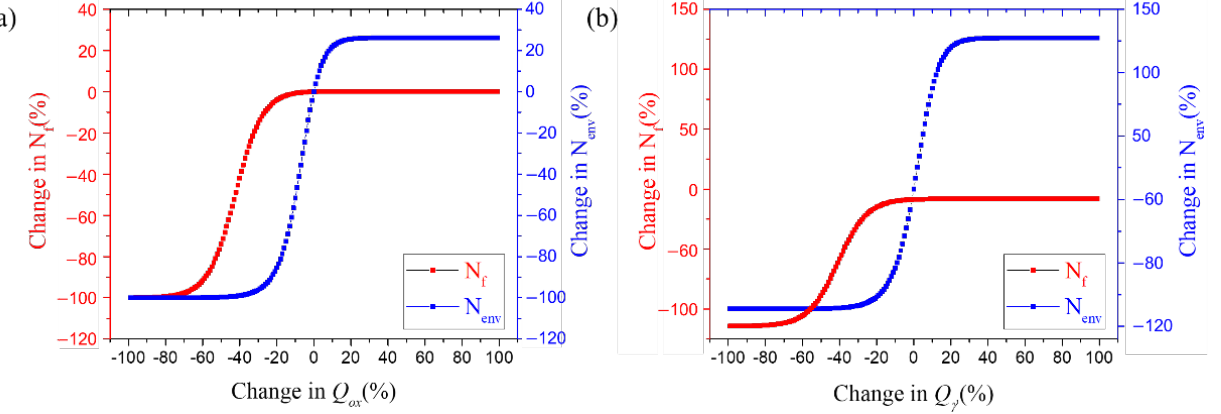
Figure 11. Fatigue life according to activation energy variable changes based on sensitivity analysis; ( a ) Q ox , ( b ) Q γ ′